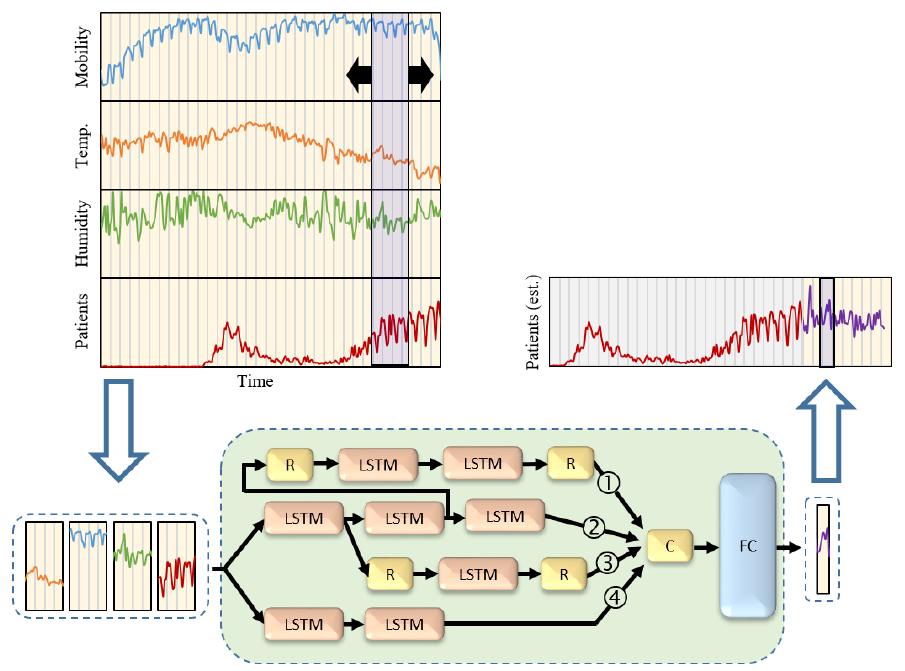
Figure 4. Proposed deep learning architecture. The LSTM network was trained using a set of time-sampled data consisting of mobility, maximum temperature, average humidity, and the cor- responding recorded COVID-19 positive cases. R, C, and FC are sequence reverse, concatenation, and fully connected layers, respectively. Labels 1 to 4 demonstrate different paths used in the ablation